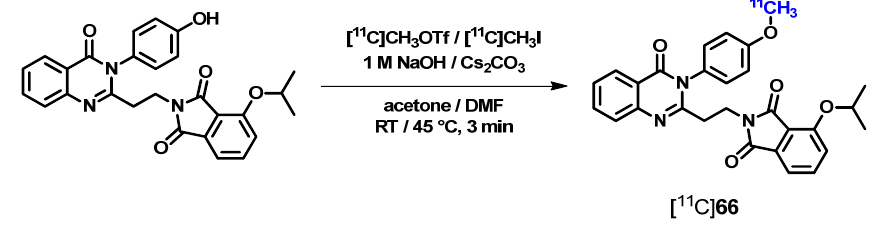
Scheme 20. Scheme 20. Radiosynthesis of [ 11 C] 66